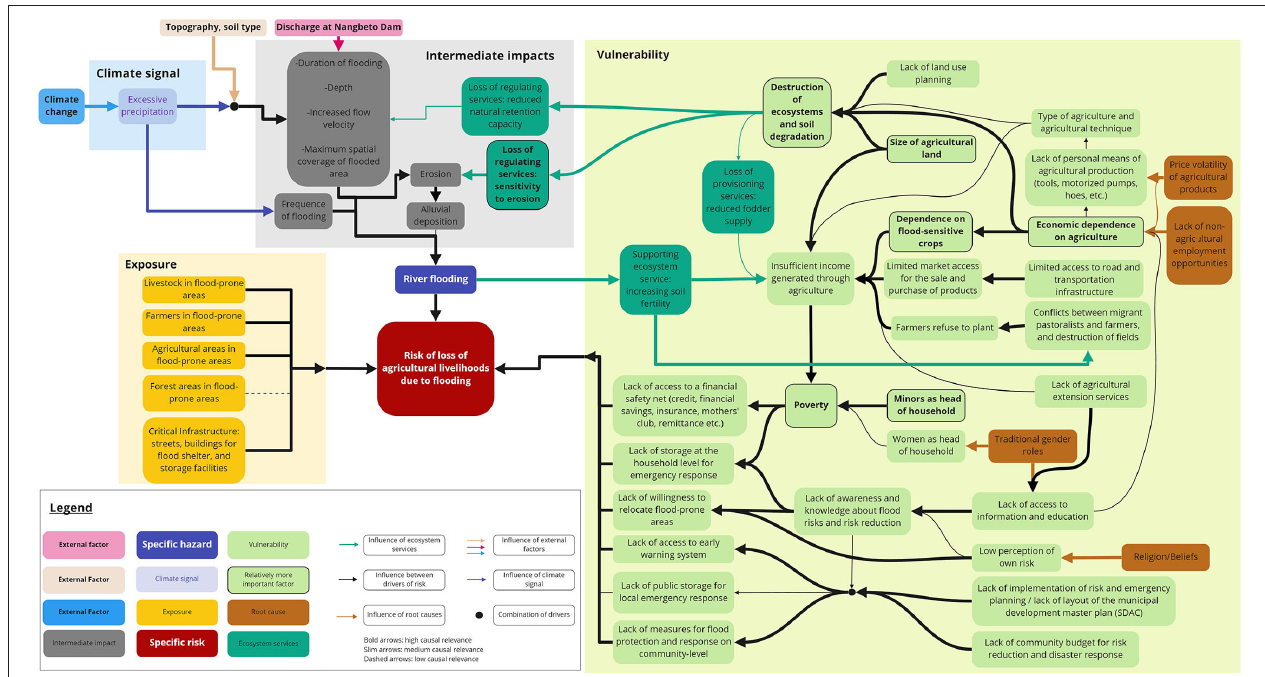
FIGURE 3 | Validated impact chain. Bold arrows: high causal influence; thin arrows: medium causal influence; dashed arrows: low causal influence. For high resolution image refer to Supplementary Figure 2 .